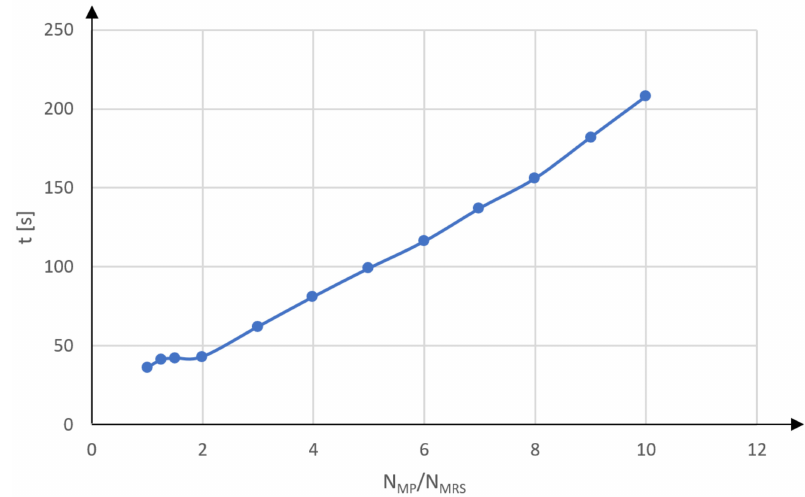
Figure 15. The impact of the ratio of the number of modular platforms and Mobile Robotic Systems on the total reconfiguration time.